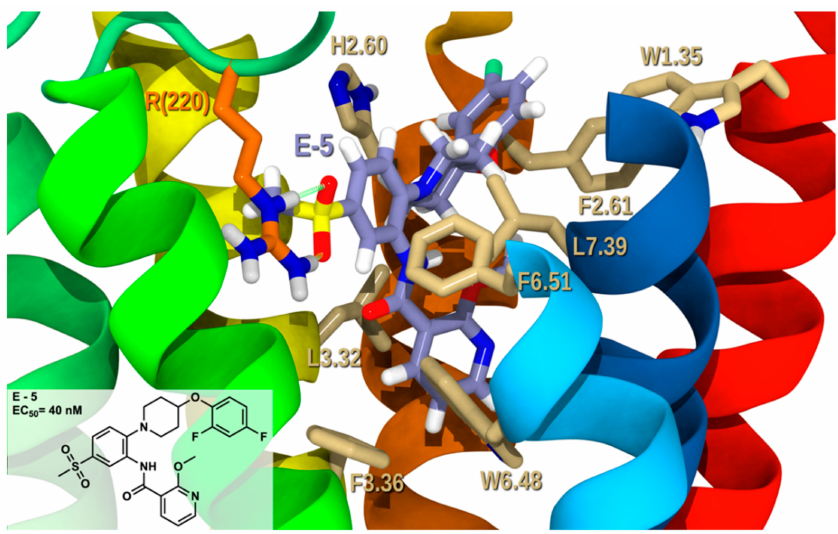
Figure 11. E-5 / GPR6 R complex. The view from the lipid bilayer with the EC portions of TMH6-7 removed for